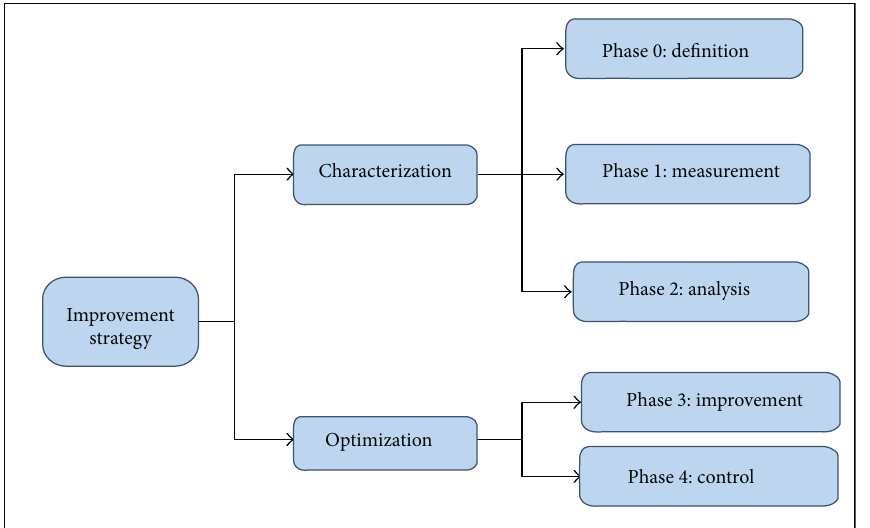
Figure 2: Improvement phases in the Six Sigma methodology (reproduced and redrawn from elsewhere